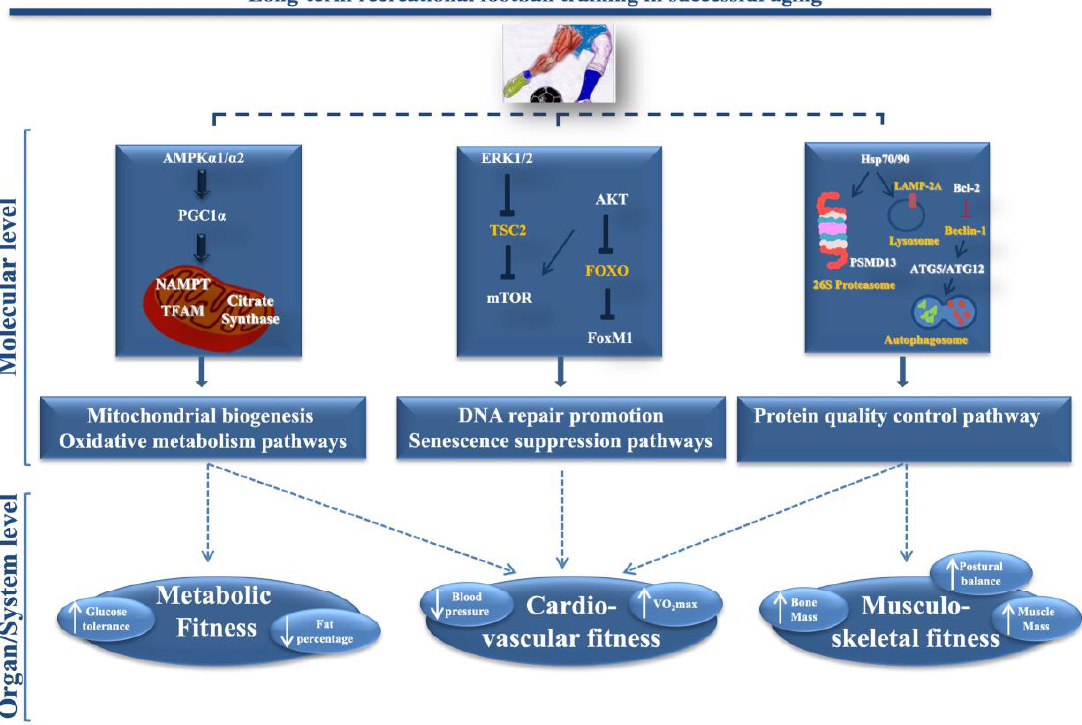
Figure 1. Long-term recreational football training in successful aging. Long-term recreational football training induces muscle molecular over-expression of key markers involved in the mitochondrial biogenesis and oxidative metabolism pathways (AMPK α1/α2, PGC1α, TFAM , NAMPT and citrate synthase activity), in DNA repair promotion and senescence suppression (ERK1/2, AKT, mTOR and FoxM1) and in the protein quality control pathway (HSP70/90, LAMP-2A, Bcl-2, ATG5-ATG12, PSMD13) and Systemic, Metabolic, Cardiovascular and Musculo-skeletal Fitness in long-term recreational football-trained older subjects . Abbreviations: AMPKα1/α2, Protein kinase, AMP- activated, α 1/α 2; PGC1α, Peroxisome proliferator-activated receptor-gamma coactivator- 1α; TFAM, Mitochondrial transcription factor A; NAMPT, Nicotinamide phosphoribosyltransferase; ERK1/2, Extracellular signal-regulated protein kinases 1 and 2; TSC2, tuberous sclerosis complex 2; mTOR, the mammalian target of rapamycin; AKT, protein kinase B; FOXO, class O of Forkhead transcription factors; FoxM1, Forkhead box protein M1; HSP, Heat Shock Proteins; LAMP-2A, lysosomal membrane type 2A protein complex; Bcl-2, anti-apoptotic B-cell lymphoma-2 protein; ATG5-ATG12, Autophagy Factors 5 and 12; PSMD13, non-ATPase subunit of the 19S regulatory complex. Adapted from Mancini et al. 2017, 2019 [92,100] and from Krustrup & Parnell, 2019 [51].